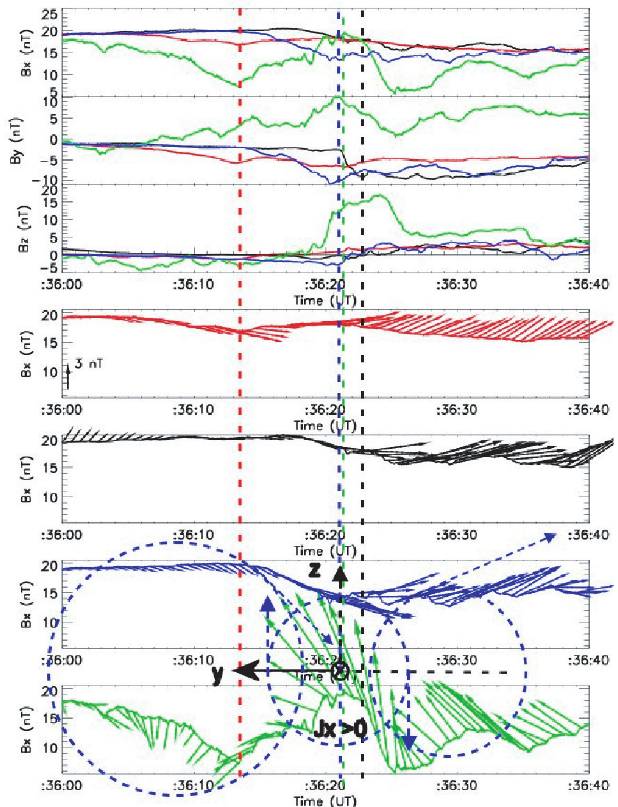
Fig. 13. (a) Magnetic field data between 21:36:00 and 21:36:40 UT, 7 September 2001. (b) Hodograms of the magnetic field projected onto the ( XY ) plane during the time interval shown in panel (a). Spacecraft are ordered by their locations along Z . B x is a proxy for the location of each S/C with respect to CS centre. Vertical dashed lines indicate the estimated closest approach, for each S/C. Dashed circles are drawn only for S/C4 (for clarity); they are tan- gent to magnetic field direction (in B y , B z plane) taken at 3 selected times. To single out the magnetic field vectors corresponding with the selected times, we have extended their lengths via dashed ar- rows. Then the magnetic field direction is used for a remote sensing of the motion of the center of current tube. As discussed in the text the current tube is found to move